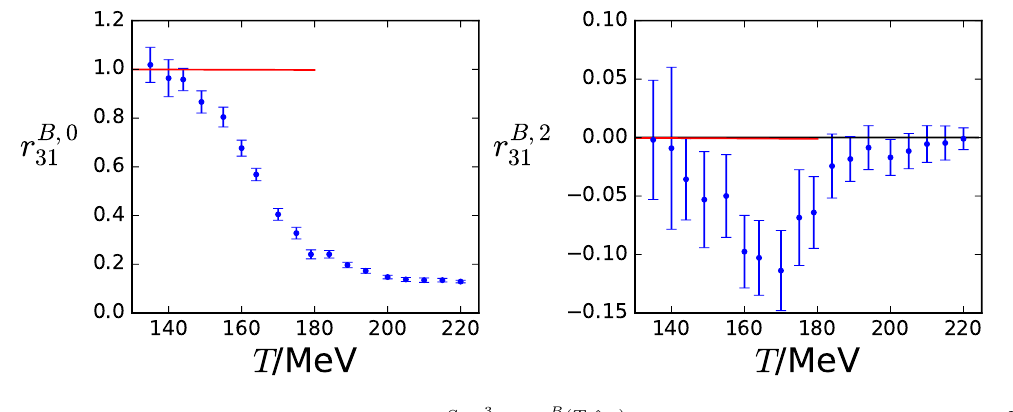
Figure 7 . Taylor expansion coe(cid:14)cients for S B (cid:27) (left panel) and r B; 2